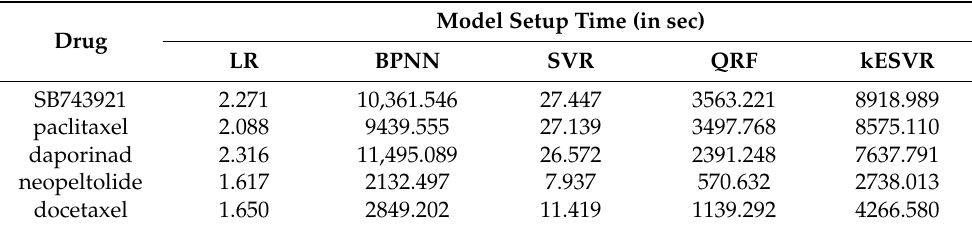
Table 5. Model setup time for 5 drugs with maximum